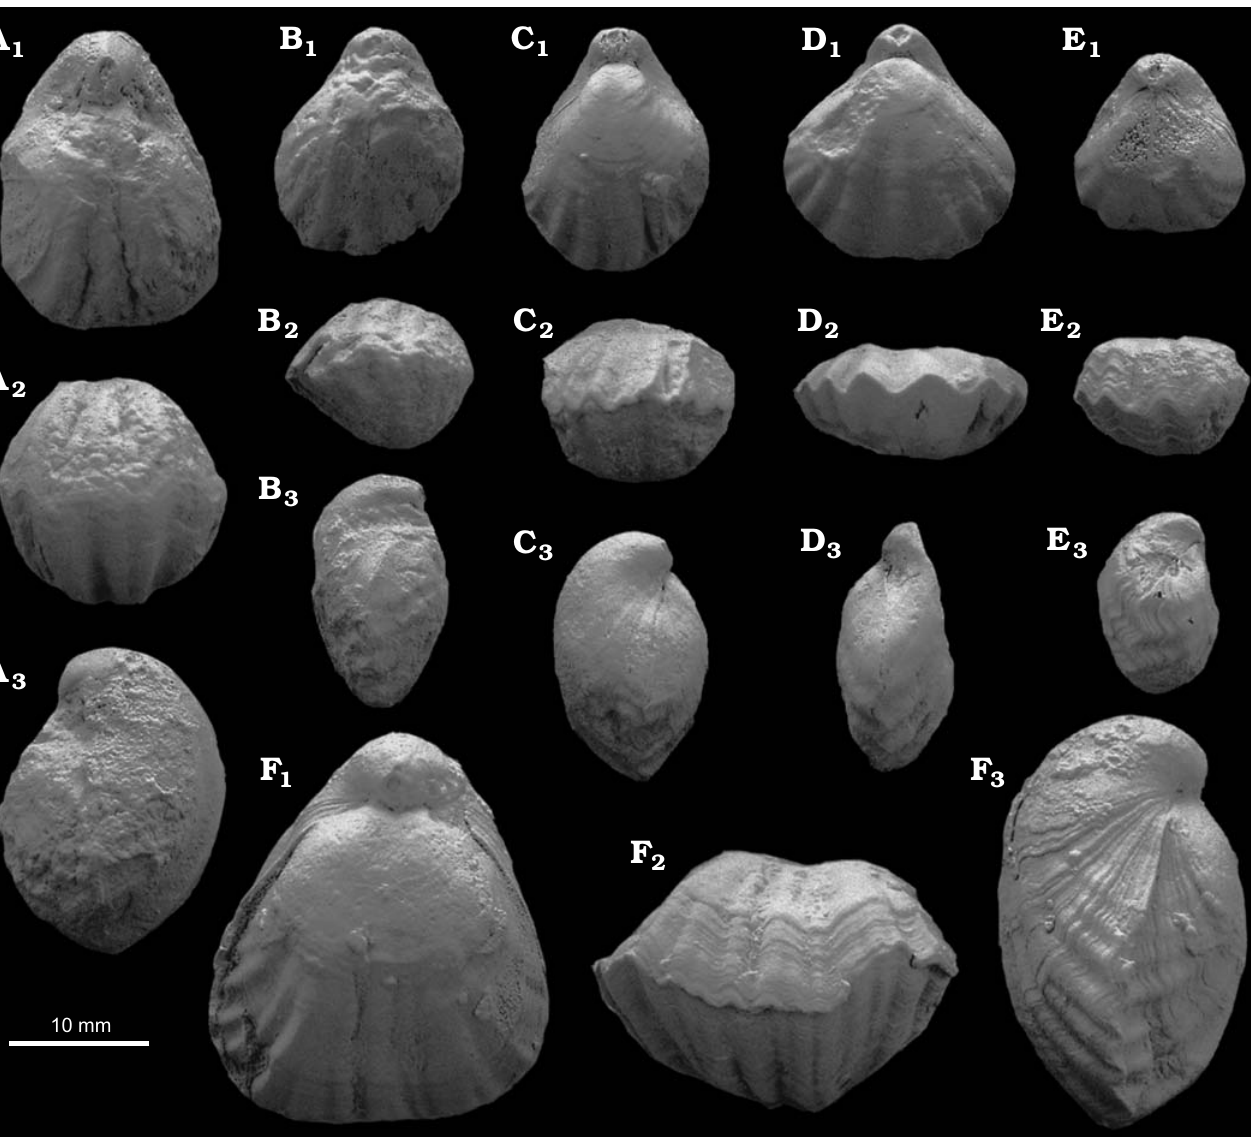
Fig. 3. Intraspecific variability of zeillerid brachiopod Misunithyris goyi gen. et sp. nov. of the lower Ladinian from the South-Iberian Triassic platform, the Arroyo Hurtado (A, B), Calasparra (C, E), Talave (D, F) sections; in dorsal (A 1 –F 1 ), anterior (A 2 –F 2 ), and lateral (A 3 –F 3 ) views. A . BQ-AH2.1. B . BQ-AH2.2, sectioned in the present work. C . BQ-CL1.1. D . BQ-TA1.1. E . BQ-CL1.2. F . BQ-TA1.2, holotype. All specimens were coated with mag- nesium